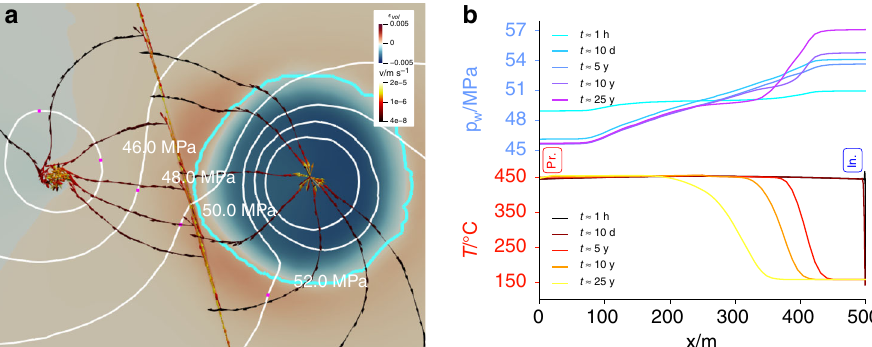
Fig. 4 Pressure distribution between the wells and deformation. a The streamlines go from the injection well to the extraction well and the volumetric strain follows the thermal fi eld after 25 years of injection. The cyan line indicates the liquid front, which is close to the fault. b The pressure distribution is asymmetrical in the long-term and the mid-point moves with time towards the injection well because of the higher viscosity of the liquid water around the injection well due to thermal quenching